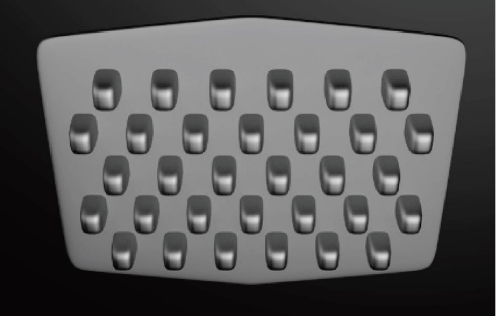
Figure 6: Anchor pylon design.